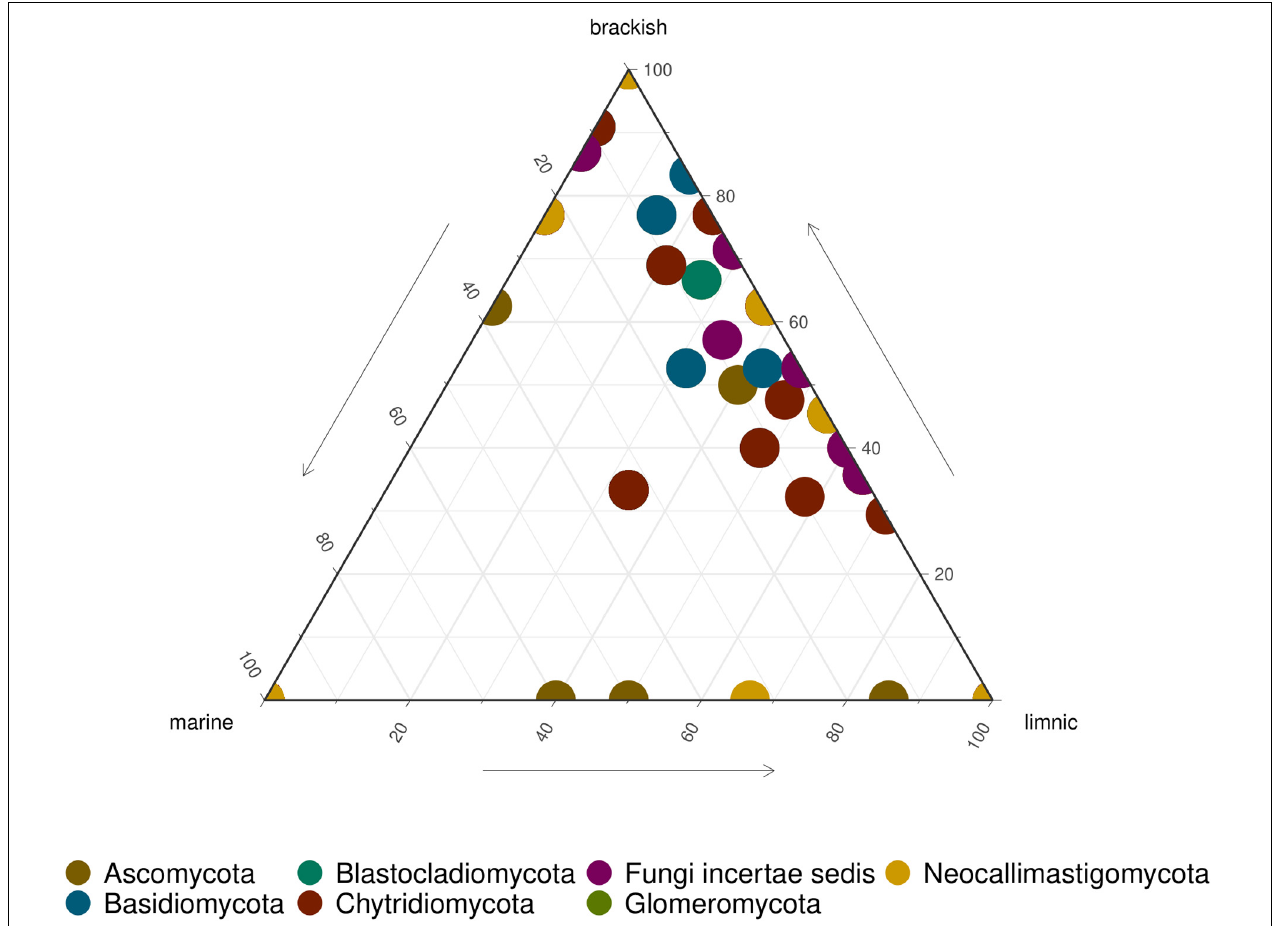
FIGURE 5 | Ternary plot showing relative abundance of fungal ASVs in LSU data. Each point represents an ASV. The position represents the relative abundance of the ASV with respect to each